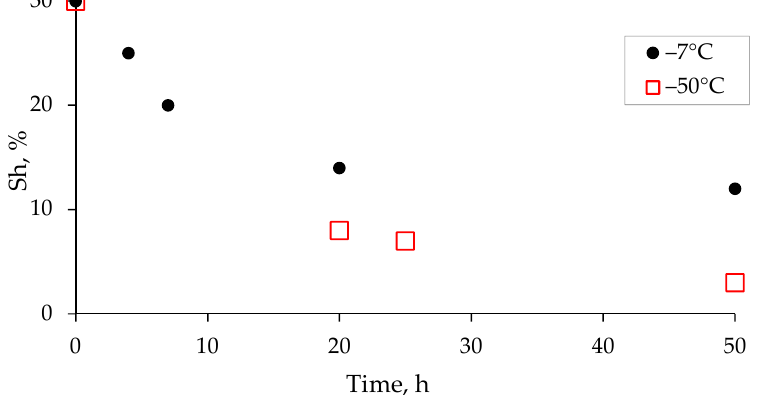
Figure 12. Time-dependent hydrate saturation in the frozen sand 1 sample with 7% of montmorillonite (W = 17%) after the pressure dropped to 0.1 MPa at −7 °С and −50 °С.